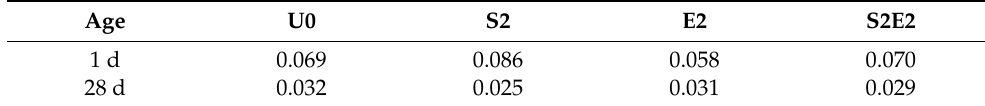
Figure 8. Incremental pore volume distribution: ( a ) 1 d. ( b ) 28 d. Table 6. Accumulative volume of 5–50 nm pore (mL/g).